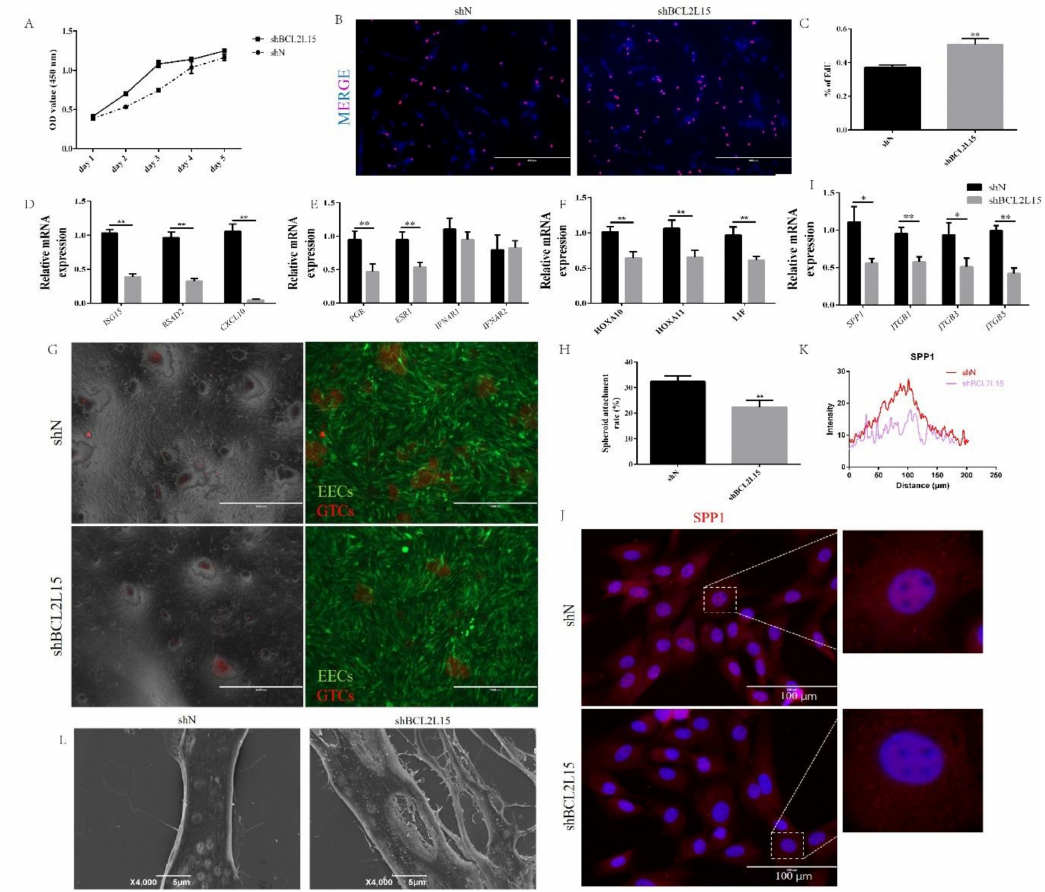
Figure 2. The e ff ects of BCL2L15 on endometrial receptivity. The lentivirus specific for BCL2L15 and a negative lentivirus (shN) infected EECs for 48 h. ( A ) The cell proliferation was measured by Cell Counting Kit-8 (CCK-8) assay. ( B , C ) The DNA synthesis was measured by 5-ethynyl-2 (cid:48)